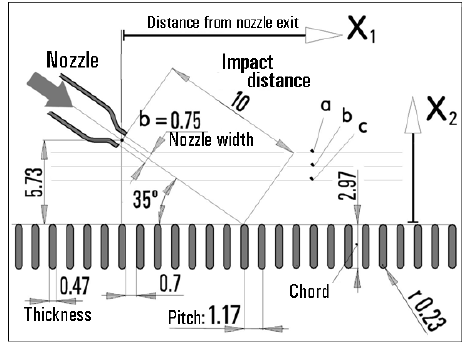
Fig. 11. Geometry of the most important part of the computation domain in the flows driven by the outflow from the inclined nozzle. Note the three parallel lines a, b , and c . In them were evaluated the velocity profiles and identified the positions of the jet flow velocity maxima.